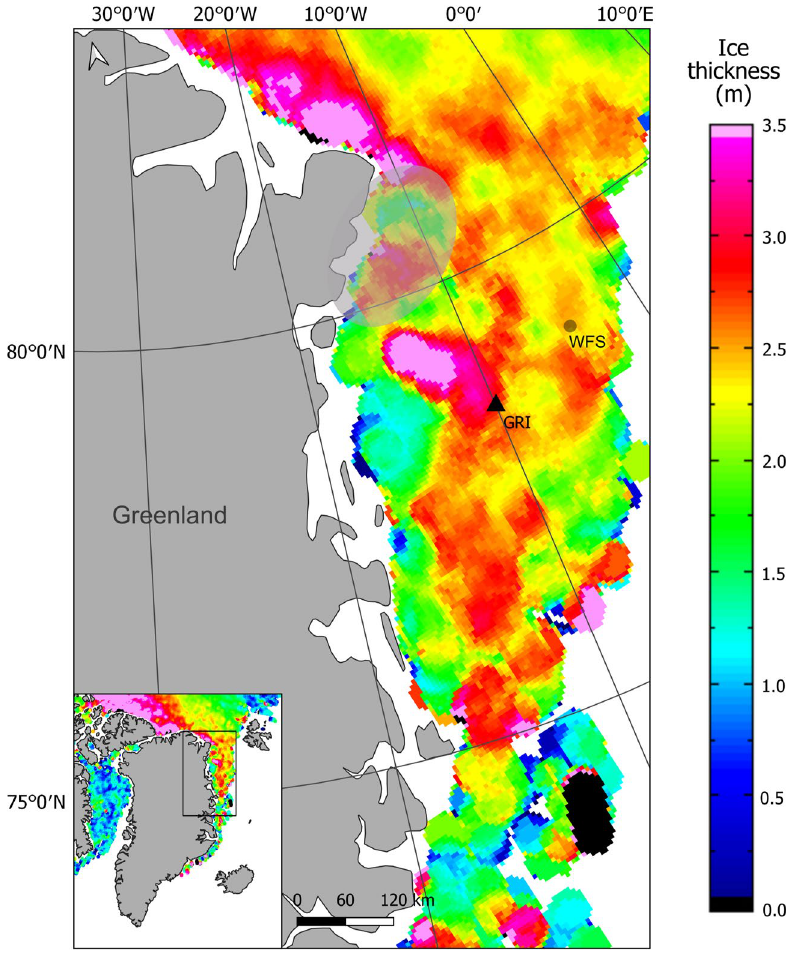
Figure 1. Map of the North East Greenland coast showing the Greenland I (GRI) recording location. Colours as shown in legend represent sea ice thickness values for December 2013 (data from CryoSat-2 68 ). The grey dot is the location of the Western Fram Strait recording location from previous studies mentioned in the text 22,33 . The grey ellipse represents the position and extent of the Northeast Water polynya. (Map created using QGIS v.3.8.3, https ://www.qgis.org/).